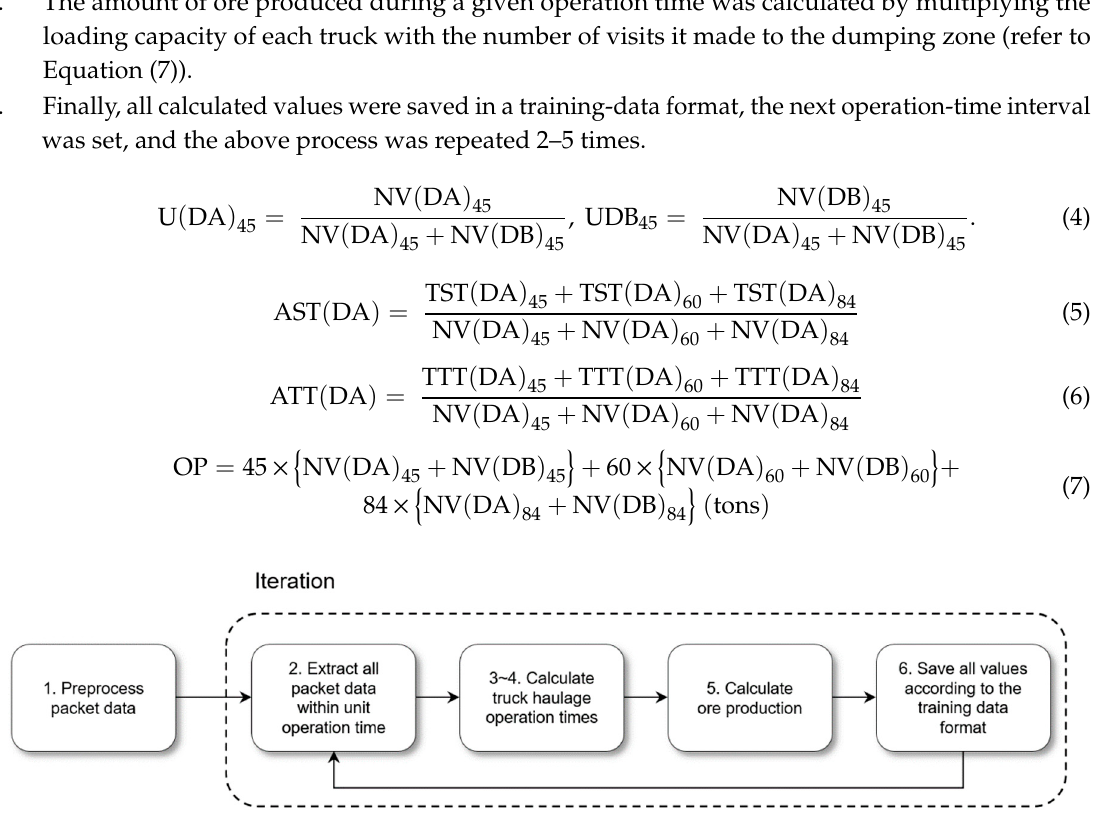
Figure 6. Training-data generation for DNN model using packet data.